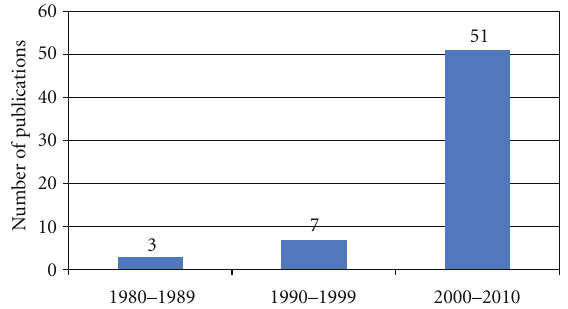
Figure 1: Decade wise publications on PHPT from India.